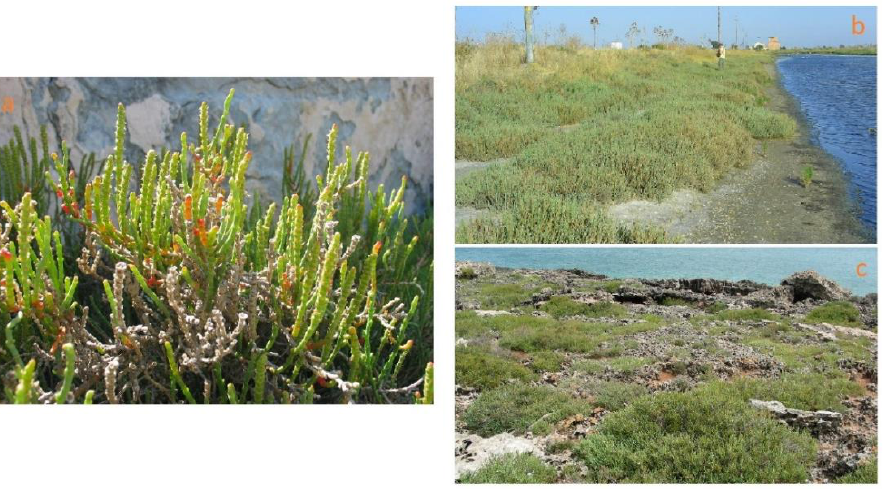
Figure 7. Arthrocaulon macrostachyum ( a ); A. macrostachyum communities at the edges of the “Capi- tanata” coastal lagoons ( ( b ); Northern Apulia) and on the rocky coasts of Torre Guaceto (( c ); Salento, Southern Apulia).